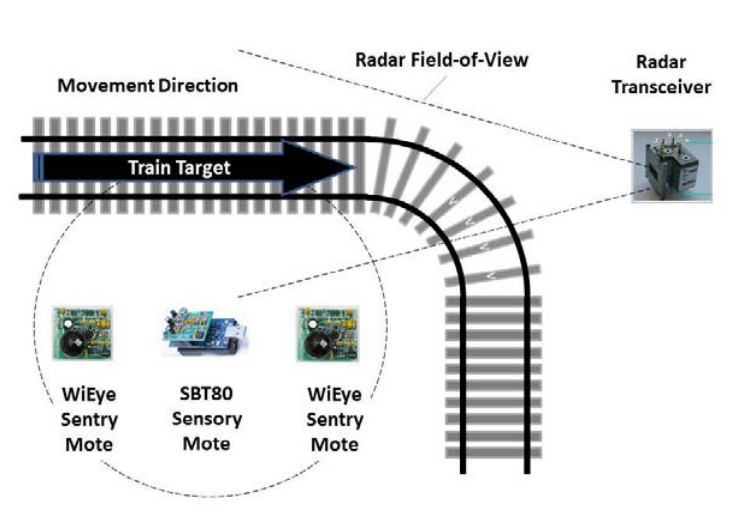
Figure 5. Experimental arrangement for the autonomous distributed sensor network, including triggering, acoustic, vibration, and radar I channel motes; mote Q is not